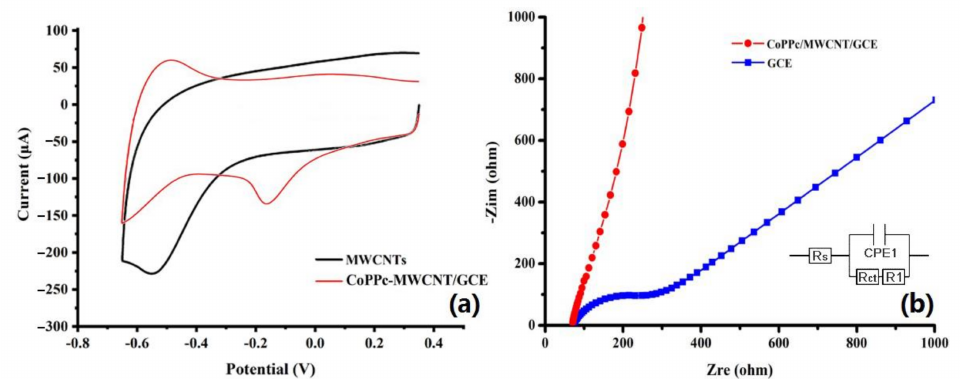
Figure 3. Cyclic voltammograms of 100 µ M lactic acid at the MWCNTs/GCE and CoPPc/MWCNTs- COOH/GCE in PBS of pH 4.0, scan rate: 50 mV s − 1 ( a ); The EIS spectra at the bare GCE and CoPPc/MWCNTs-COOH/GCE in the presence of the mixture of 5 mM Fe(CN) 63 − /4 − and 100.0 mM KCl ( b